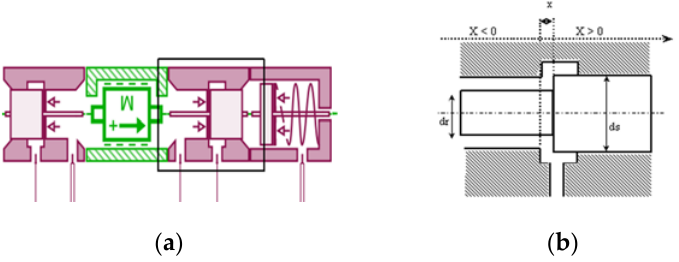
Figure 18. AMESim submodel and structure diagram of the lower chamber of series dual ‐ chamber air brake valve. ( a ) Submodel of the lower chamber of series dual ‐ chamber air brake valve; ( b ) diagram of spool valve with annular orifice of PNAO001 .